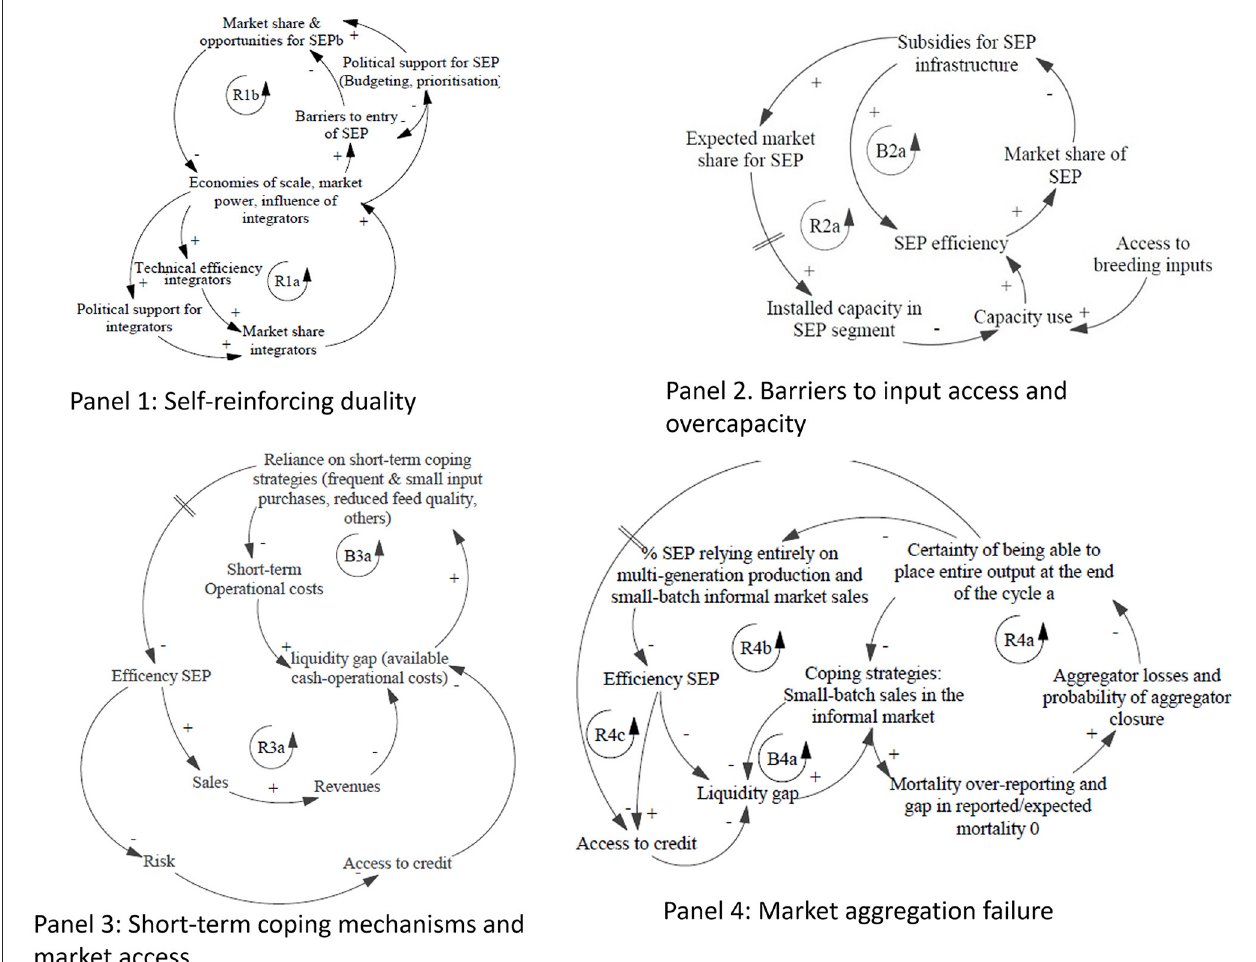
FIGURE 1 | Partial causal loop diagrams. Feedback loops are marked and labelled, R for reinforcing loops and B for Balancing loops. These letters are followed by a number that corresponds to the panel and a letter that differentiates the different feedback loops within one panel (e.g., R1a is the first reinforcing feedback loop in panel 1). Arrows indicate causality. The signs + /- next to an arrow indicate the nature of the relationship between the two variables linked by the arrow. If an increase in the causal variable leads, all else equal, to an increase (decrease) in the caused variable, the sign will be positive (negative). Panels are labelled with short descriptive titles that refer to the main mechanisms